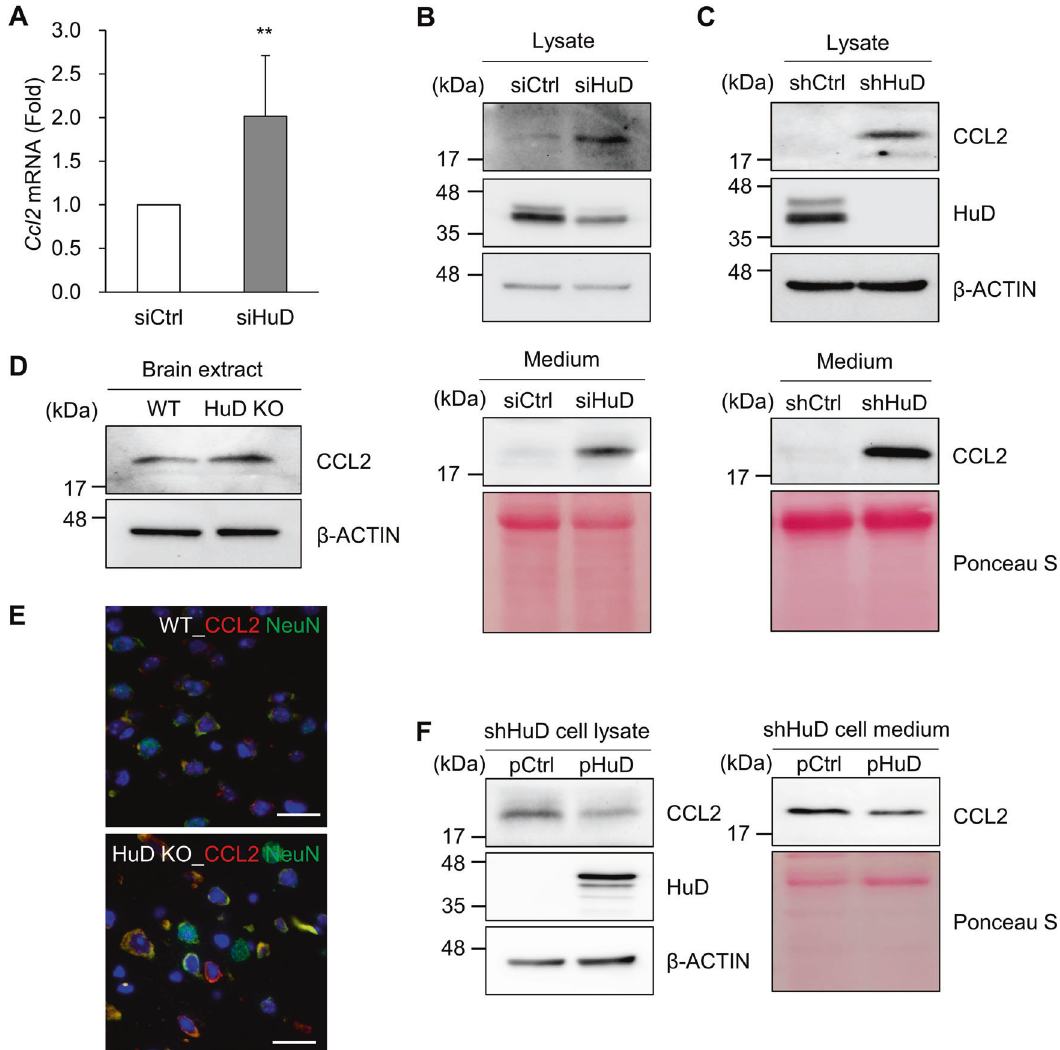
Fig. 3 Augmented expression of CCL2 by HuD knockdown. A Following the transfection of N2a cells with either control siRNA or HuD siRNA, the expression of Ccl2 mRNA was determined via RT-qPCR. Gapdh mRNA was used for normalization. B , C The relative levels of CCL2 protein in both lysates ( top ) and culture media ( bottom ) were assessed via western blotting analysis in siRNA transfected cells ( B ) and stable cells ( C ). D , E Endogenous CCL2 levels in the brain of HuD KO mice and age-matched WT mice were assessed via western blotting analysis ( D ) and immuno fl uorescence microscopy ( E ). n = 3, Red: CCL2, green: NeuN, blue: nuclei. Scale bar, 20 μ m. F N2a_shHuD cells were transiently transfected with plasmids (pHuD or control plasmid) and CCL2 levels in both lysates and media were determined by western blotting analysis. β -ACTIN blot and Ponceau S staining were used as loading controls. Images are representative, and data indicate the mean ± SEM from three independent experiments. The statistical signi fi cance of the data was analyzed via Student ’ s t -test; ** p <